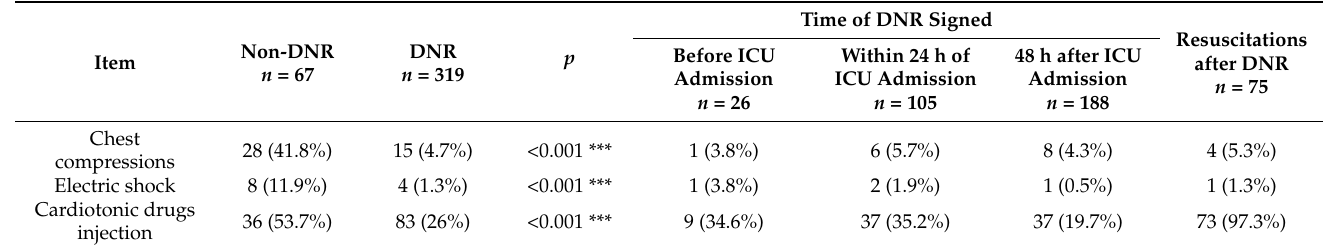
Table 3. Influence of DNR signing and timing on predeath resuscitation practice.